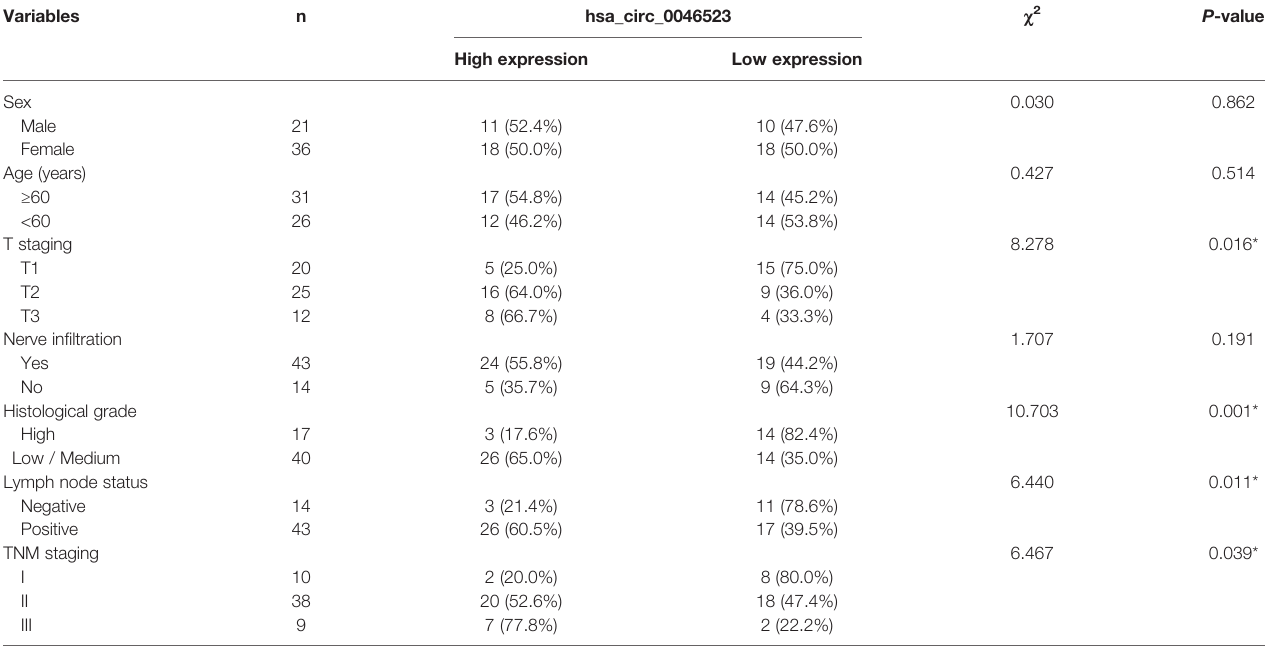
TABLE 1 | Correlation between expression of hsa_circ_0046523 and clinicopathological parameters of 57 PC patients.